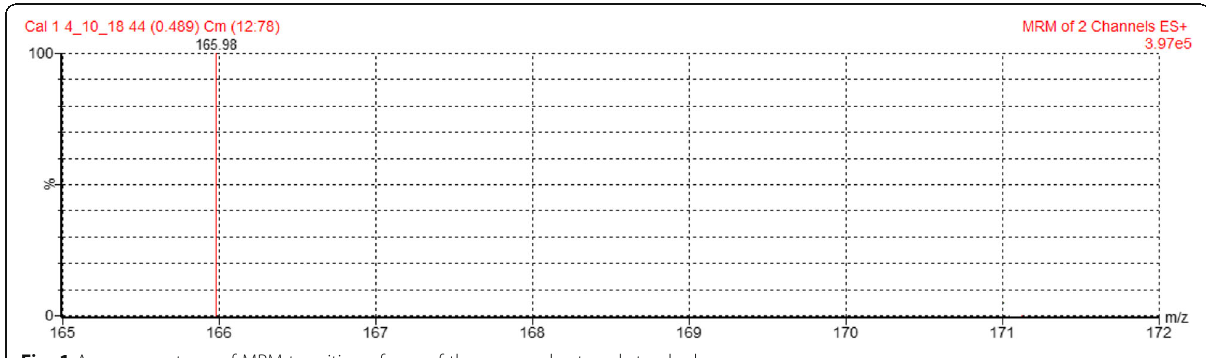
Fig. 1 A mass spectrum of MRM transition of one of the prepared external